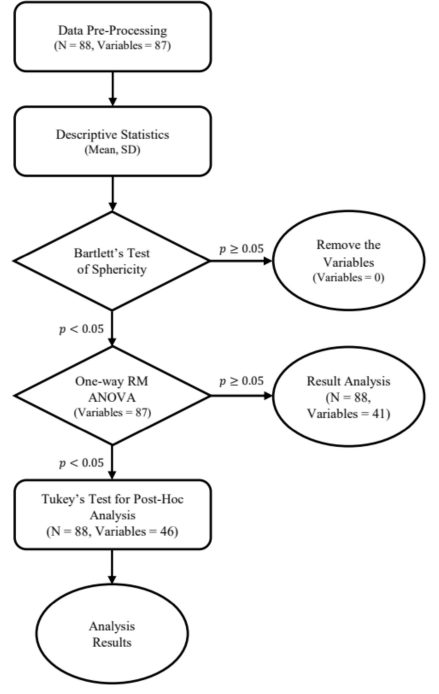
Figure 3. Data analysis process